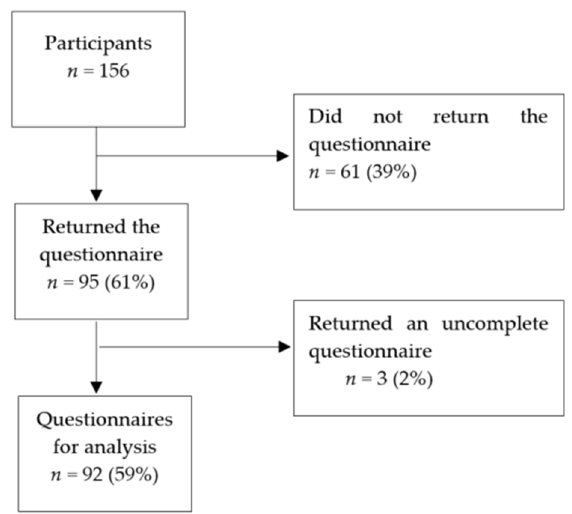
Figure A1. Flowchart of Last Aid course participants, respondents and included questionnaires.